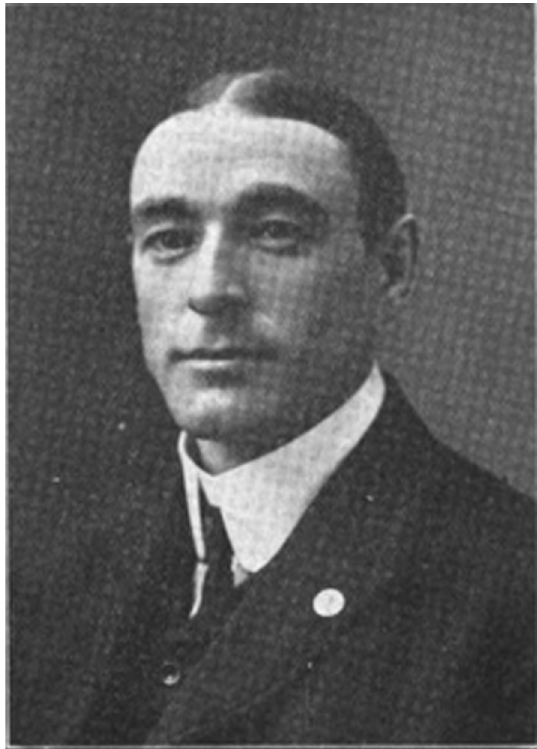
Figure 7: Frank C. Hogan, Irish American traveling salesman and possible composer of the “Swede from North Dakota,” from a biographical feature in the trade journal Mississippi Valley Lumberman , 1914. (Author’s